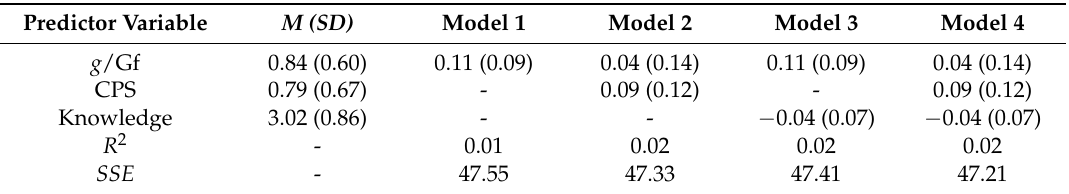
Table 6. Regression models for Job Zone 4 (DV: natural log median annual wages, ln). Predictor Variable